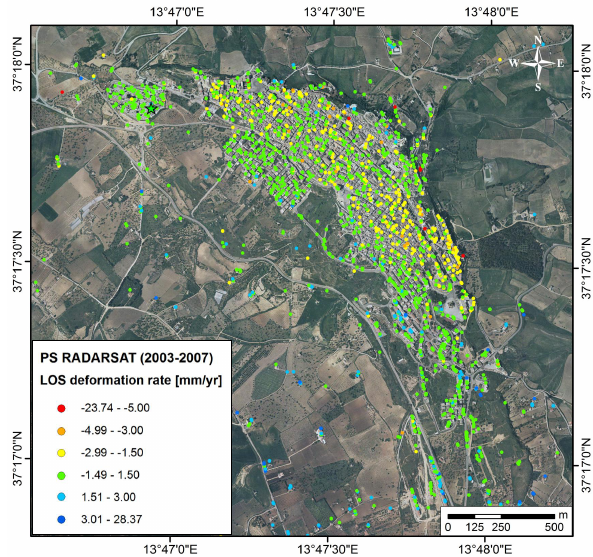
Fig. 7. PS ground deformation rates in the town of Naro in 2003–2007, measured along the LOS of RADARSAT-1 (Standard Beam, mode 3) satellite in ascending acquisition mode (see also Fig. 5b). Negative deformation values indicate movement toward the satellite; positive values indicate movement away from the satellite. The reference point location (green star) is also